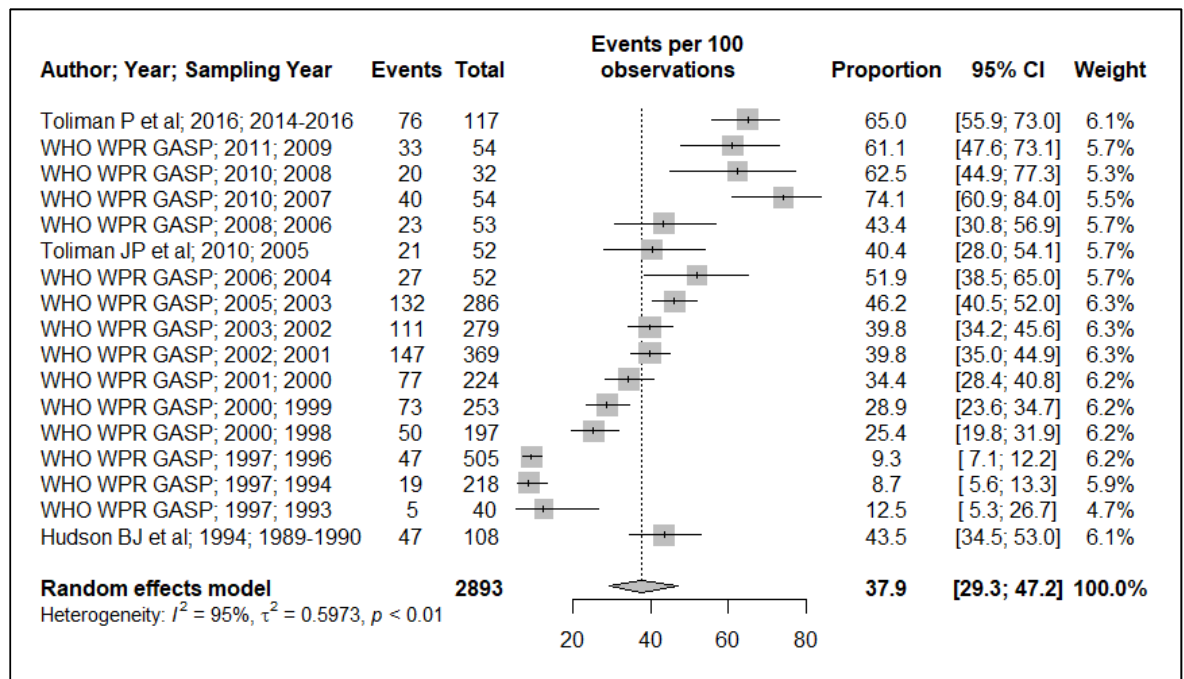
Figure 2. Penicillinase-producing N. gonorrhoeae positive strain prevalence estimate. Forest plots in-